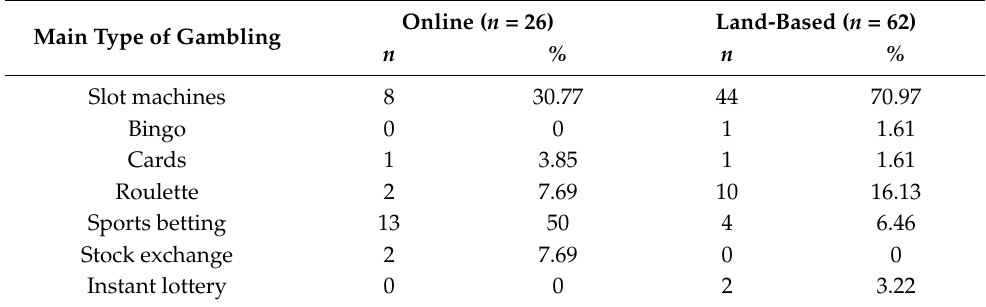
Table 1. Description of the type of gambling for the online and land-based gambling